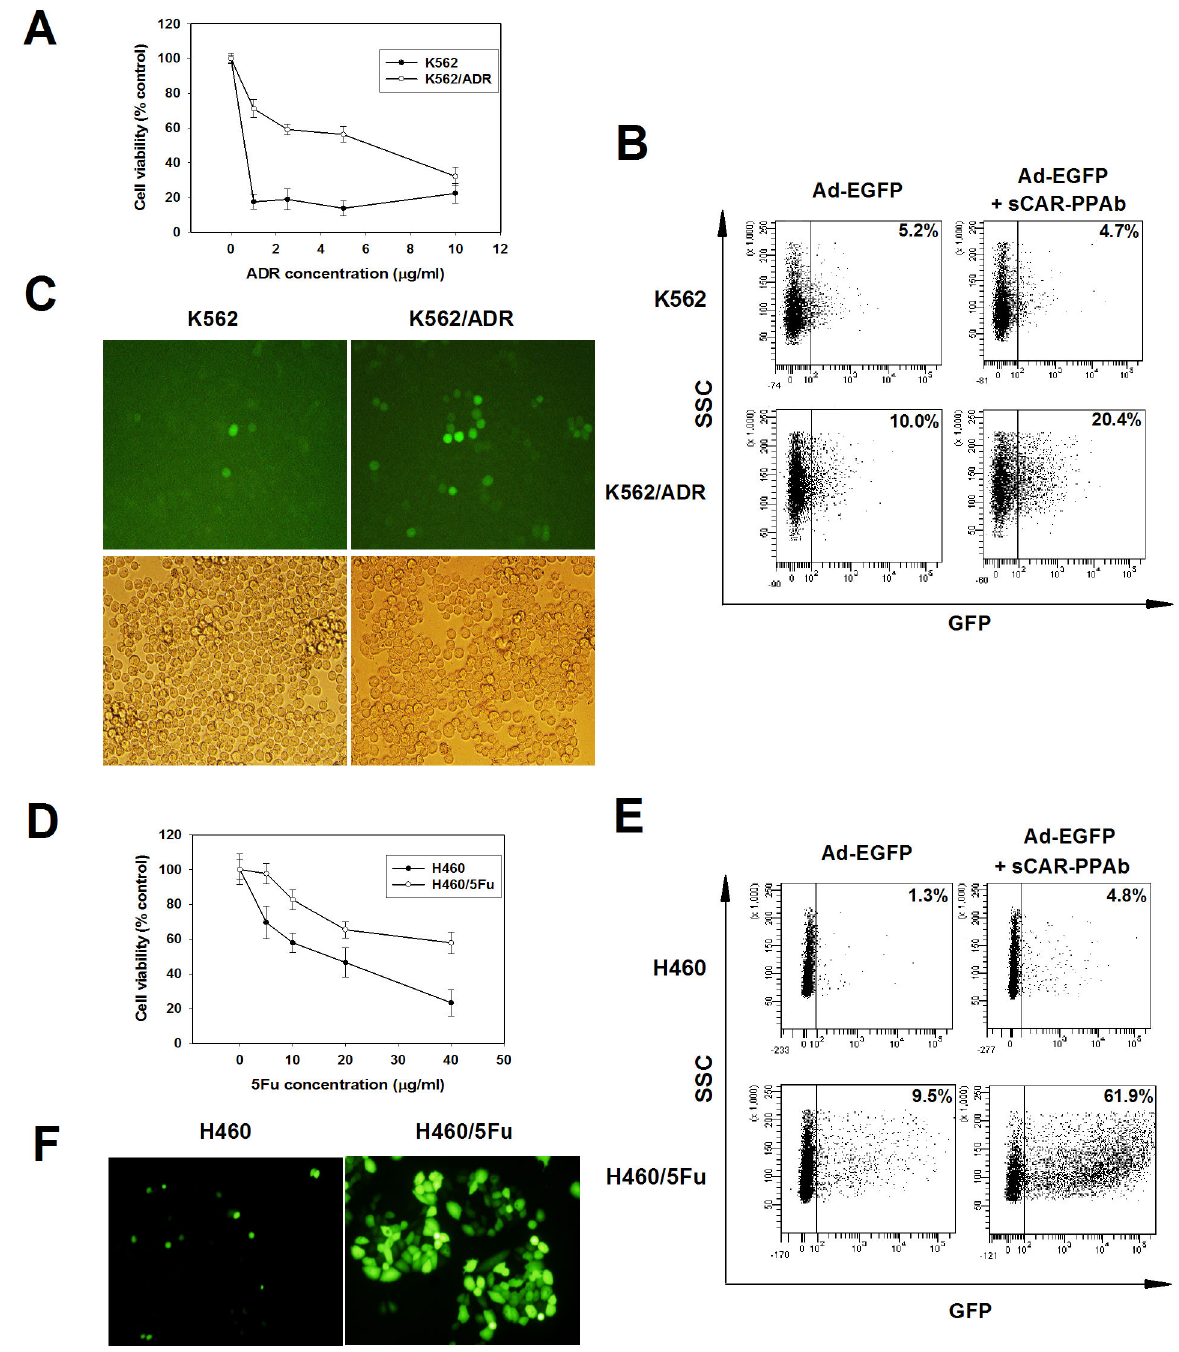
Figure 1. PPA preferentially recognizes drug resistant cancer cells. A. The sensitivity of K562 and K562/ADR to ADR was determined by a MTT assay. B. K562 or K562/ADR cells were treated with sCAR-PPAb combined with Ad-EGFP or PBS for 48h. The portion of EGFP positive cells was analyzed by flow cytometry. Shown is a representative from 3 separate experiments. C. K562 or K562/ADR cells treated with sCAR-PPAb combined with Ad-EGFP for 48h were examined using a fluorescence microscope. D. The sensitivity of H460 and H460/5Fu to 5Fu was determined by a MTT assay. E. H460 or H460/5Fu cells were treated with sCAR-PPAb combined with Ad-EGFP or PBS for 48h. The portion of EGFP positive cells was analyzed by flow cytometry. Shown is a representative from 3 separate experiments. F. H460 or H460/5Fu cells treated with sCAR-PPAb combined with Ad-EGFP for 48h were examined using a fluorescence microscope.